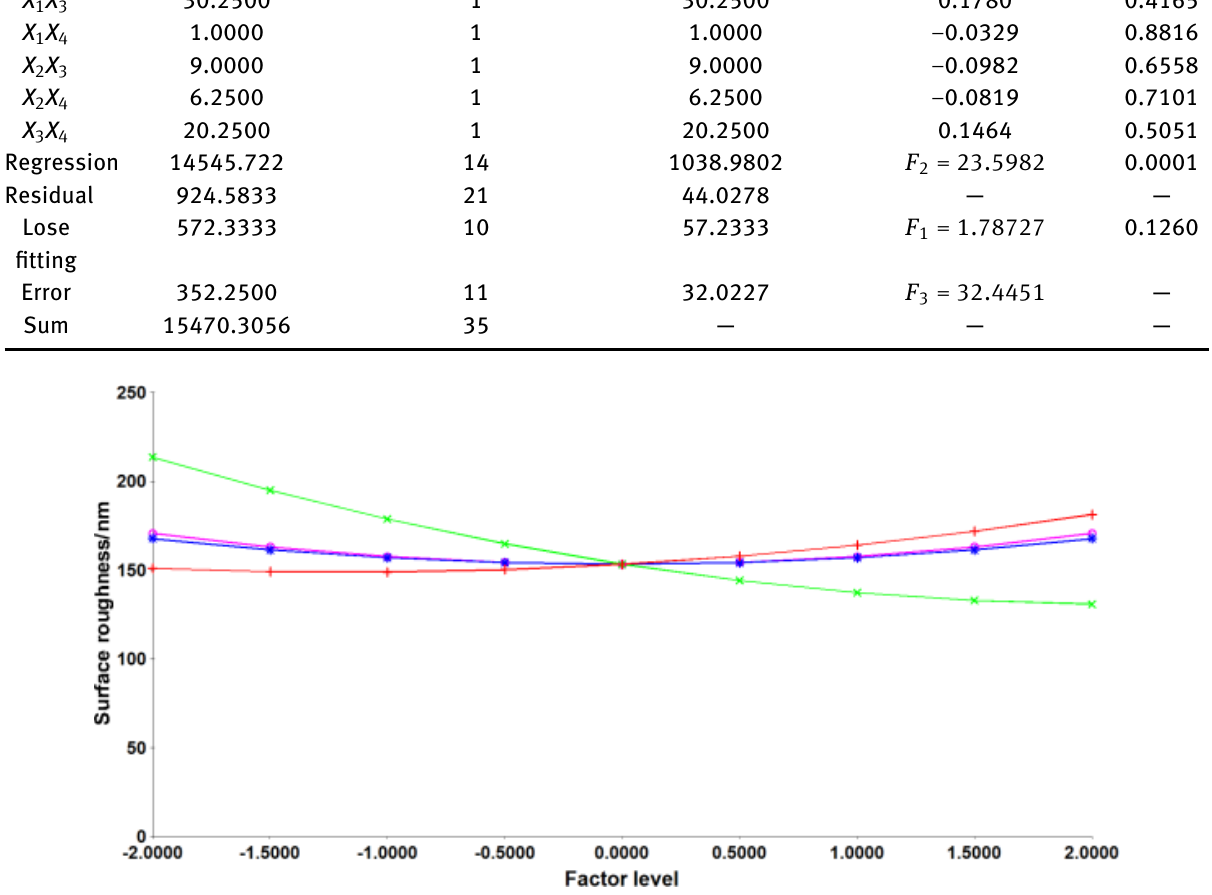
Figure 7: Effect of various factors on surface roughness